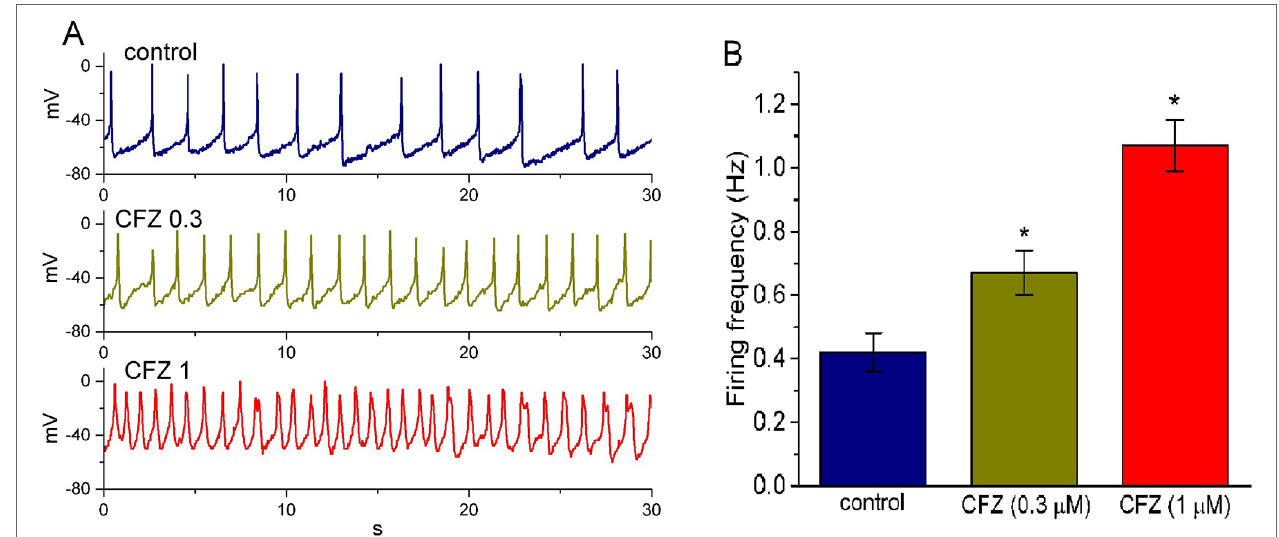
FIGURE 6 | Effect of CFZ on spontaneous action potentials (APs) in GH 3 cells. The experiments were conducted in cells bathed in normal Tyrode’s solution containing 1.8 mM CaCl 2 . As whole-cell configuration was achieved, the recording model was rapidly switched to current-clamp condition for measuring any changes in membrane potential. (A) Representative potential changes obtained in the absence (control) of CFZ and the presence of 0.3 µM CFZ (CFZ 0.3) and 1 µM CFZ (CFZ 1). (B) Bar graph depicting efficacy of CFZ to elevate the firing frequency of spontaneous APs in GH 3 cells (mean ± SEM; n = 9 for each bar). *Significantly different from control ( P < 0.05).